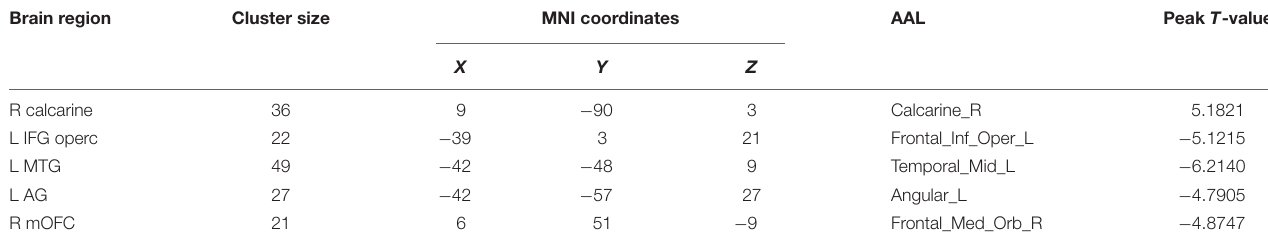
TABLE 2 | Brain regions with abnormal ReHo in ASD boys. Brain region Cluster size MNI coordinates AAL